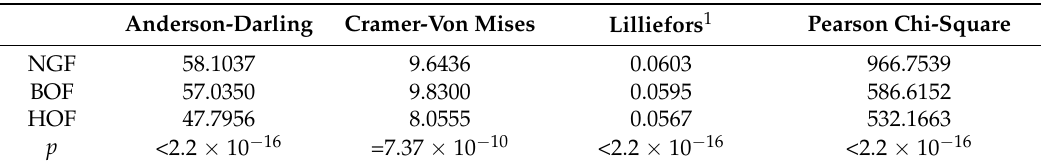
Table 2. Normality Tests.